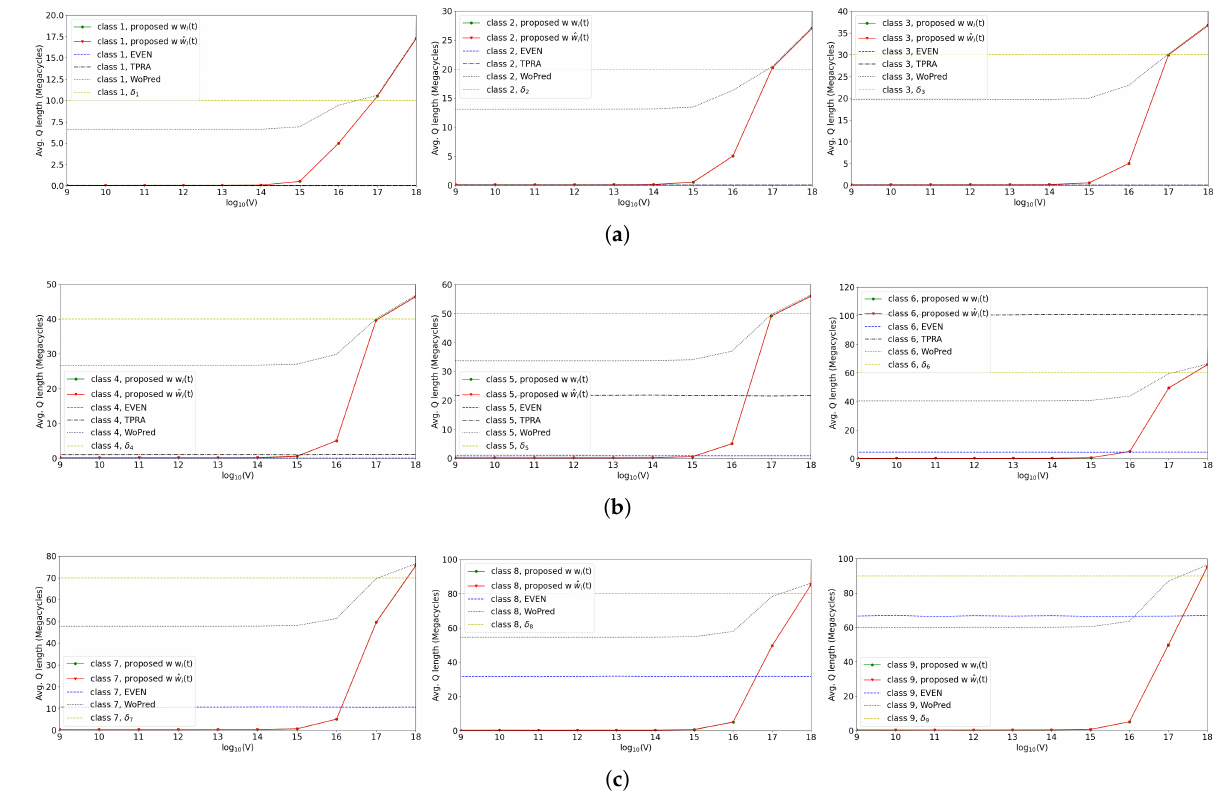
Figure 9. Average queue length with different Vs when the number of classes is 9. In Classes 7–9, the average queue lengths obtained by TPRA are much larger than those achieved by other methods.